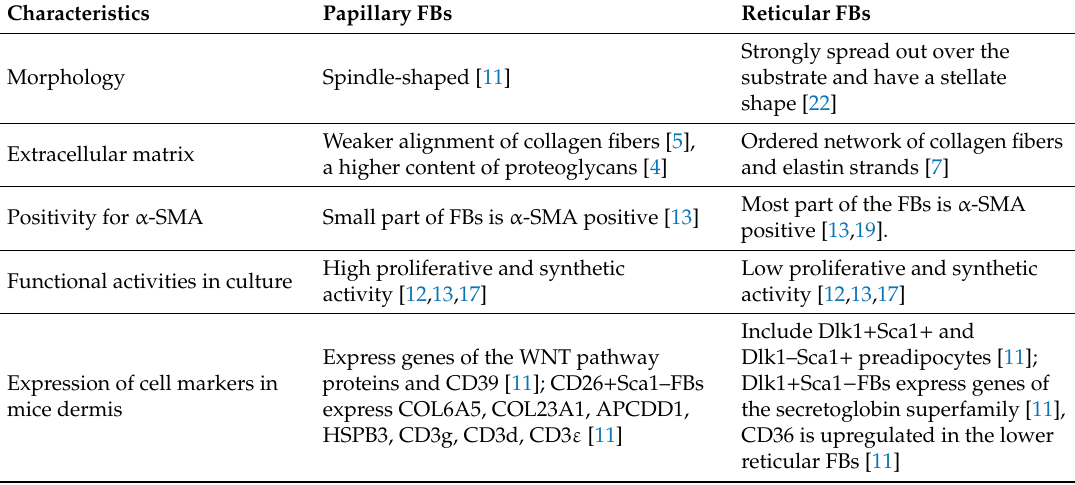
Table 1. Characteristics of papillary versus reticular